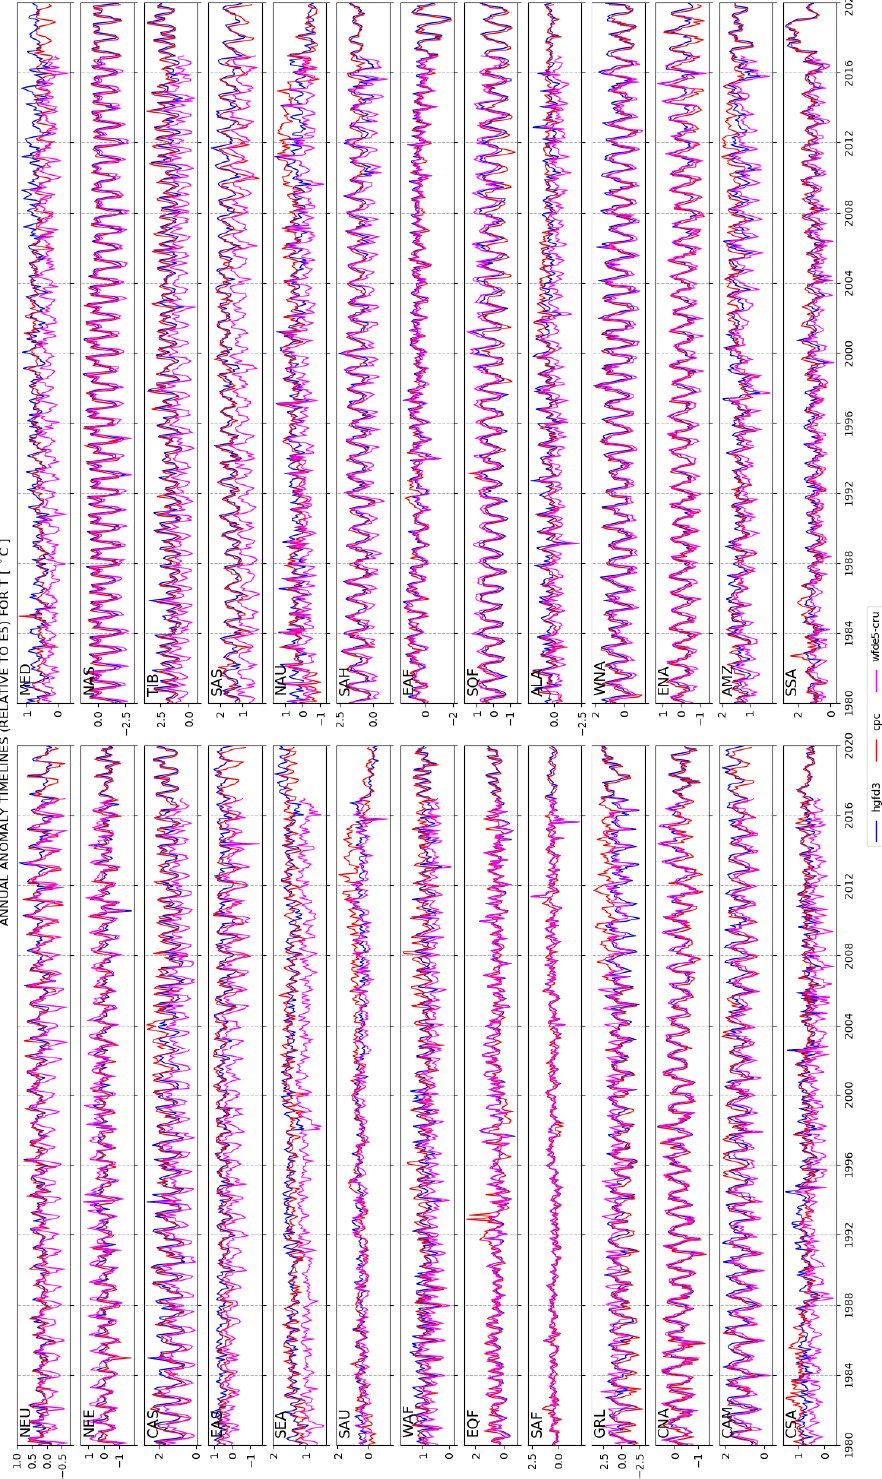
Figure 10. Monthly T anomalies for all data sets, averaged over the Giorgi regions for all valid land data points. The anomalies are relative to the e5 data set and are evaluated for each single